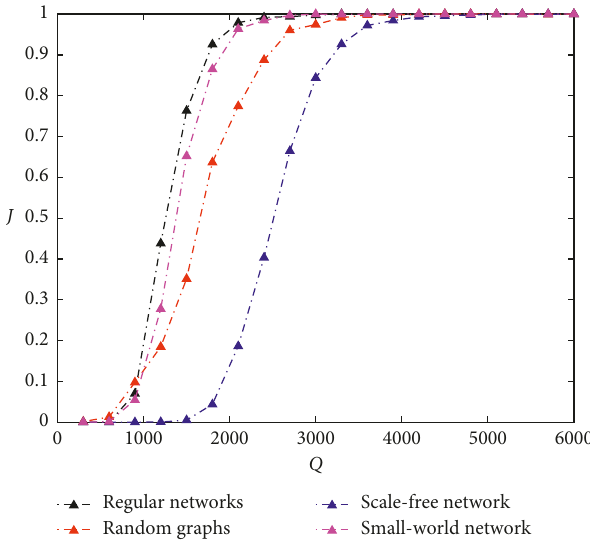
Figure 6: Network performance as the total traffic flow